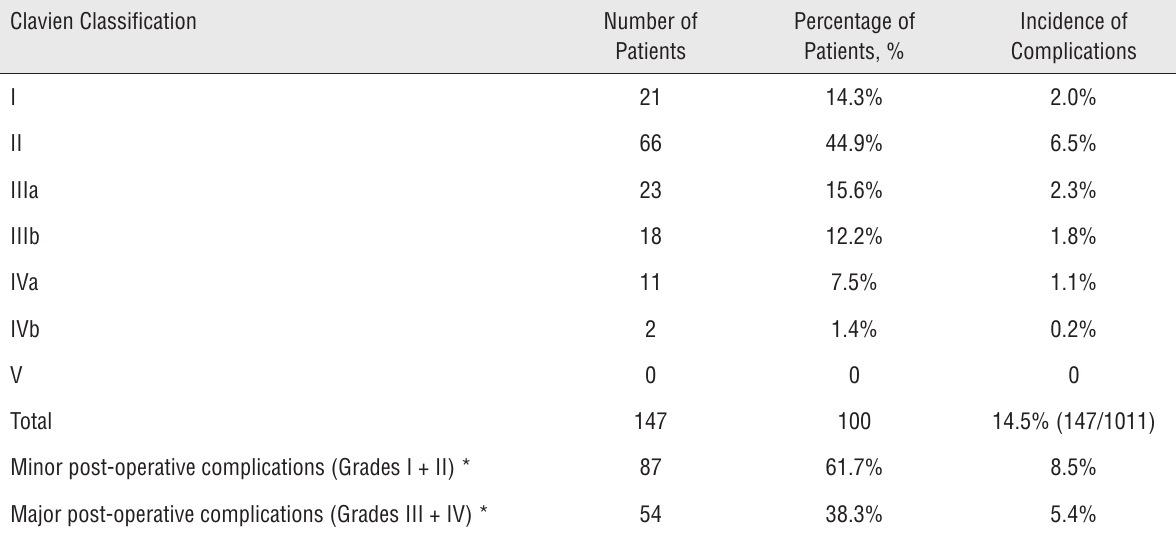
Table 4 – Complications